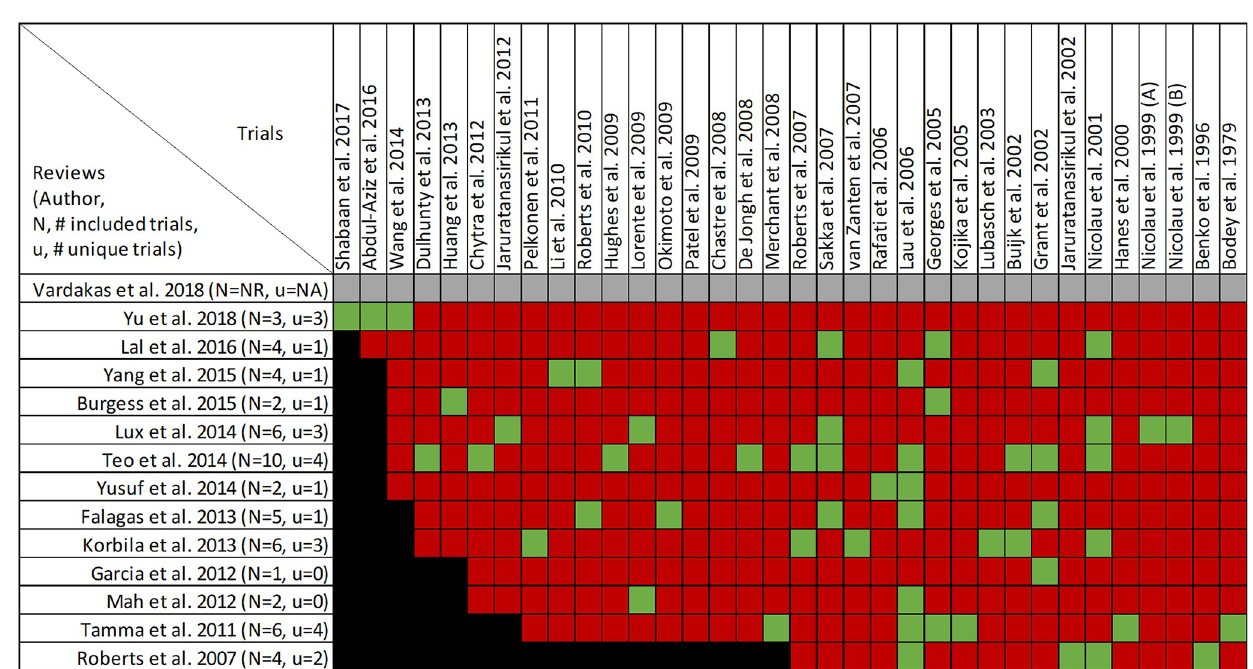
Fig 14. Citation matrix for review reporting adverse events of prolonged infusions versus intermittent infusions of beta-lactams. Green—primary studies included in systematic review, Red—primary study not included in systematic review, Black—primary studies published after systematic review and therefore ineligible for possible inclusion, Grey—included primary studies not reported for the specified